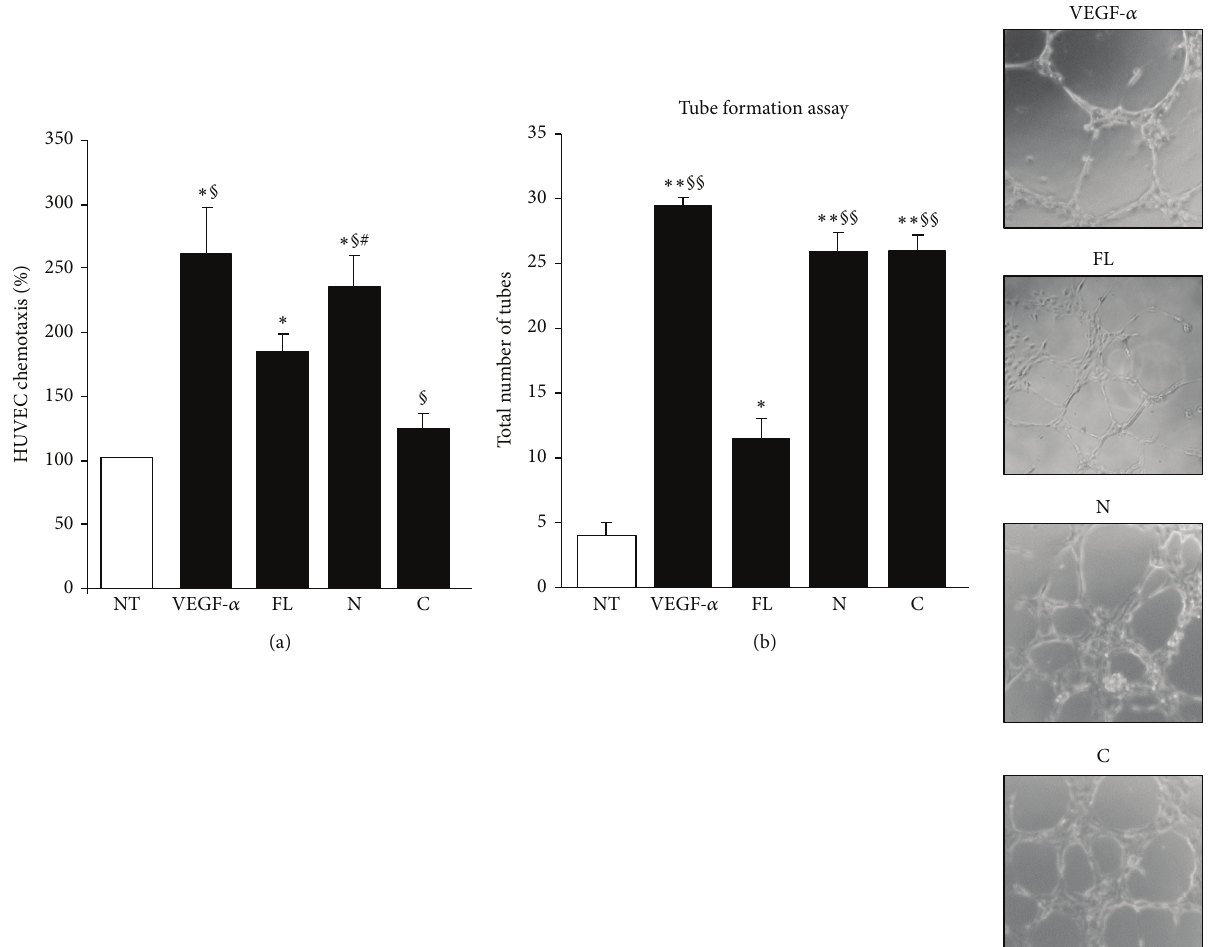
Figure5:EffectofOPNvariantsonangiogenesis.(a)HUVECswereplatedontotheapicalsideofmatrigel-coatedfiltersin50 𝜇 Lofmediumin the presence or absence of either 10 𝜇 g/mL OPN-FL, 5 𝜇 g/mL OPN-N, or OPN-C; VEGF- 𝛼 (10ng/mL) was loaded in the basolateral chamber as a positive control for migration. The cells that migrated to the bottom of the filters were stained using crystal violet and counted (5 fields for each triplicate filter) using an inverted microscope. Results are expressed as in Figure 4. (b) In the tube formation assay, HUVECs were plated in the presence and absence of OPN-FL (10 𝜇 g/mL), OPN-N (5 𝜇 g/mL), OPN-C (5 𝜇 g/mL), or VEGF- 𝛼 (10ng/mL), as a control. The morphology of capillary-like structures formed by HUVECs was analyzed 6 h after culturing. Results are expressed as means ± SEM from 3 experiments ( ∗ 𝑝 < 0.05 ; ∗∗ 𝑝 ≤ 0.01 versus the control; § 𝑝 < 0.05 ; §§ 𝑝 ≤ 0.01 versus OPN-FL; # 𝑝 < 0.05 ; versus OPN-C; Wilcoxon’s signed rank test). Right panels show a representative tubulogenesis